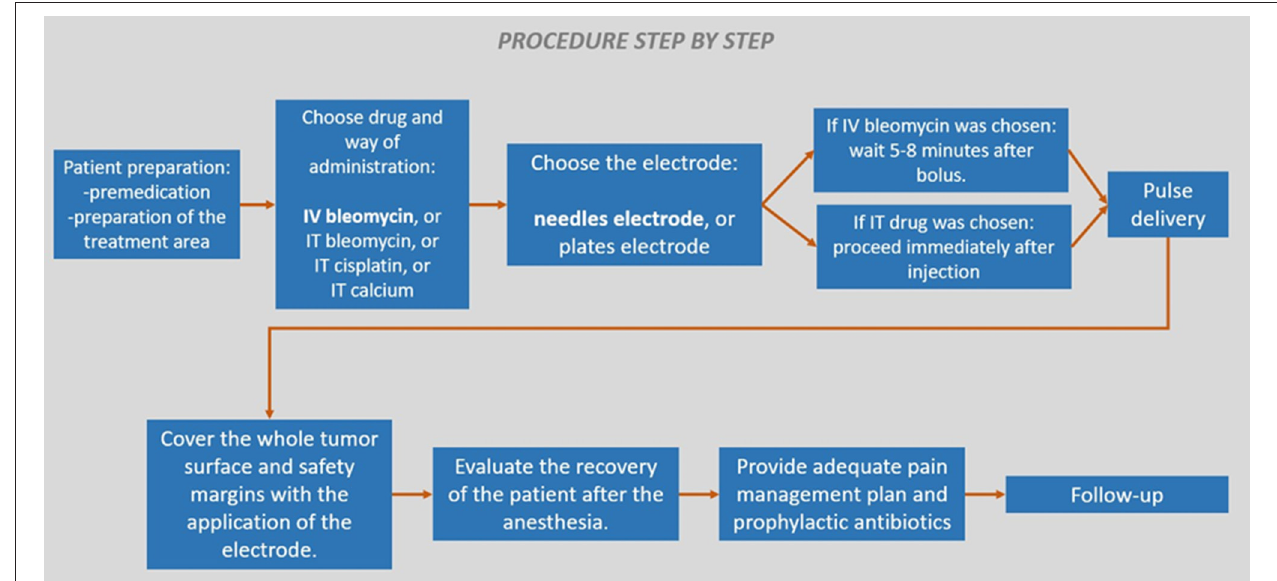
FIGURE 9 | Electrochemotherapy procedure step by step. In bold, the preferred choices when